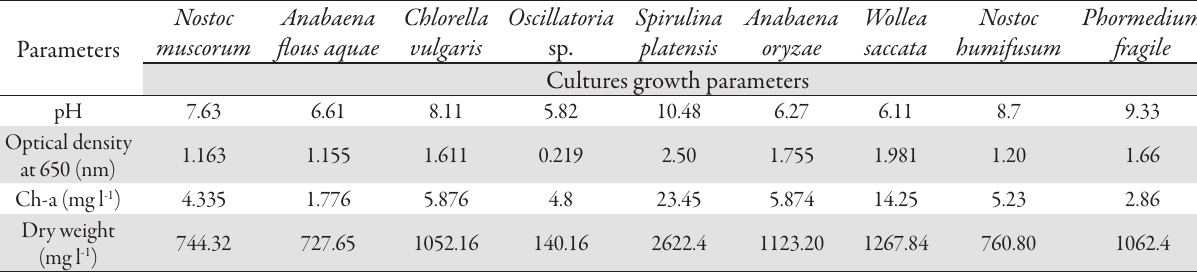
Tab. 1. The growth parameters of the microalgae cultures